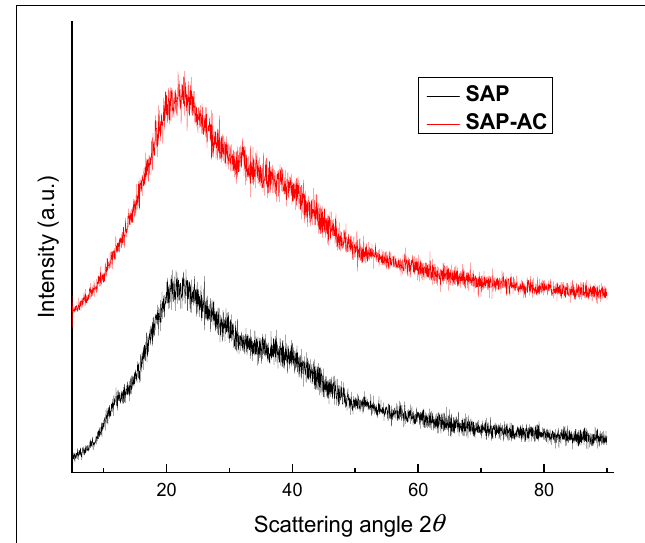
Figure 15. XRD pattern of SAP and its composite.